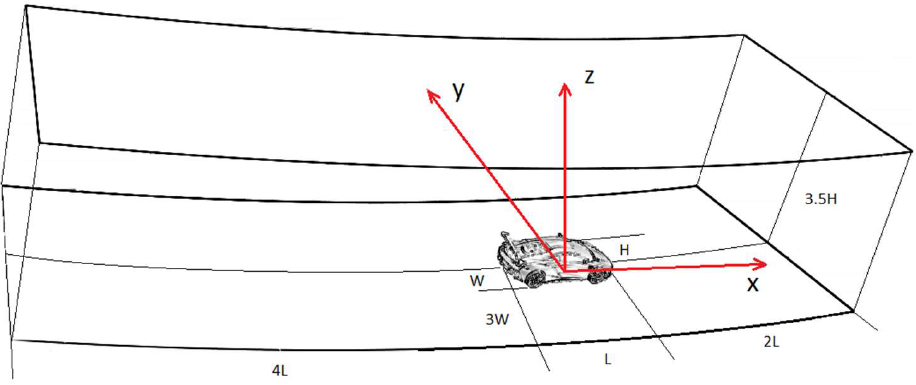
Figure 3. Size of the arch computational domain with length L = 4.75 m, height H = 1.2 m, and width W = 2.05 m.